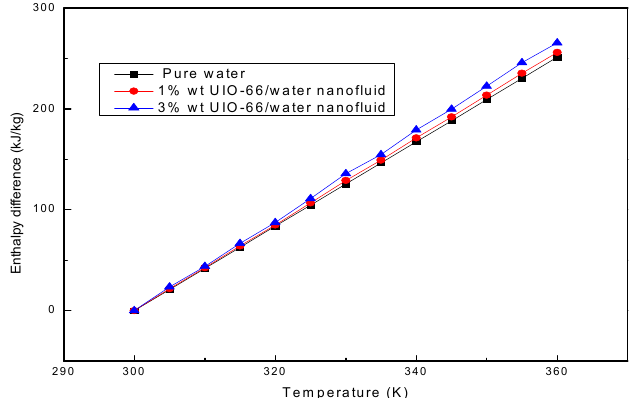
Figure 3. The enthalpy differences of water and UIO-66/H 2 O nanofluids assessed by theoretical calculation.